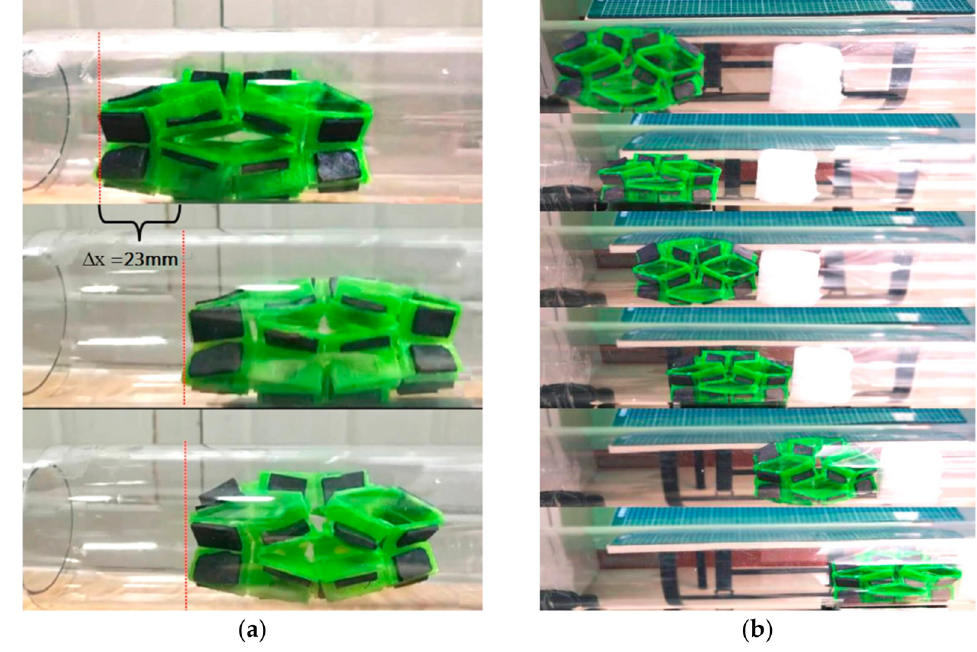
Figure 10. In-pipelocomotionoftheorigamiflexiballrobot: ( a )undulatorymotion, ( b